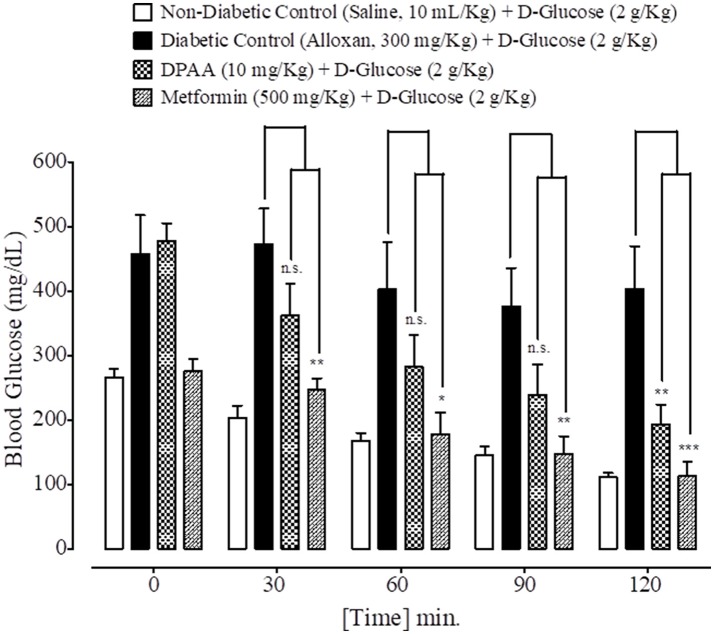
Bar graph representing blood glucose levels at different time intervals (0–120 min.) after administration of oral glucose load in mice of saline treated group (non-diabetic control), alloxan treated group (diabetic control), bis (diphenylacetato) cadmium (II) (DPAA) treated group and metformin pre-treated group. Data expressed as mean ± SEM. Statistical analysis used one-way ANOVA, followed by post-hoc Tukey's test. *P < 0.05, **P < 0.01, ***P < 0.001 comparison of the blood glucose levels of DPAA and metformin treated group vs. diabetic control group. n.s., non-significant. The sample size in each group comprised of five mice (n = 5).